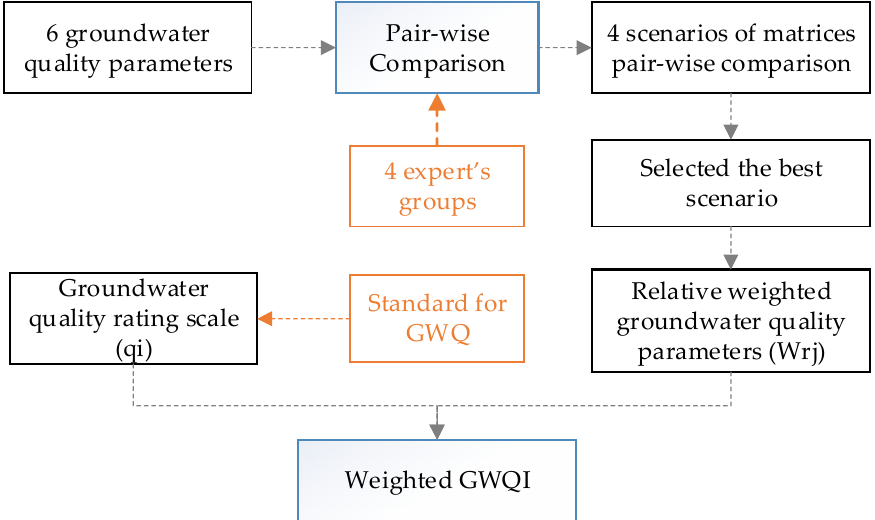
Figure 3. Flowchart of study progress of weighted groundwater quality indices by using the fuzzy analytic hierarchy process (Fuzzy-AHP).